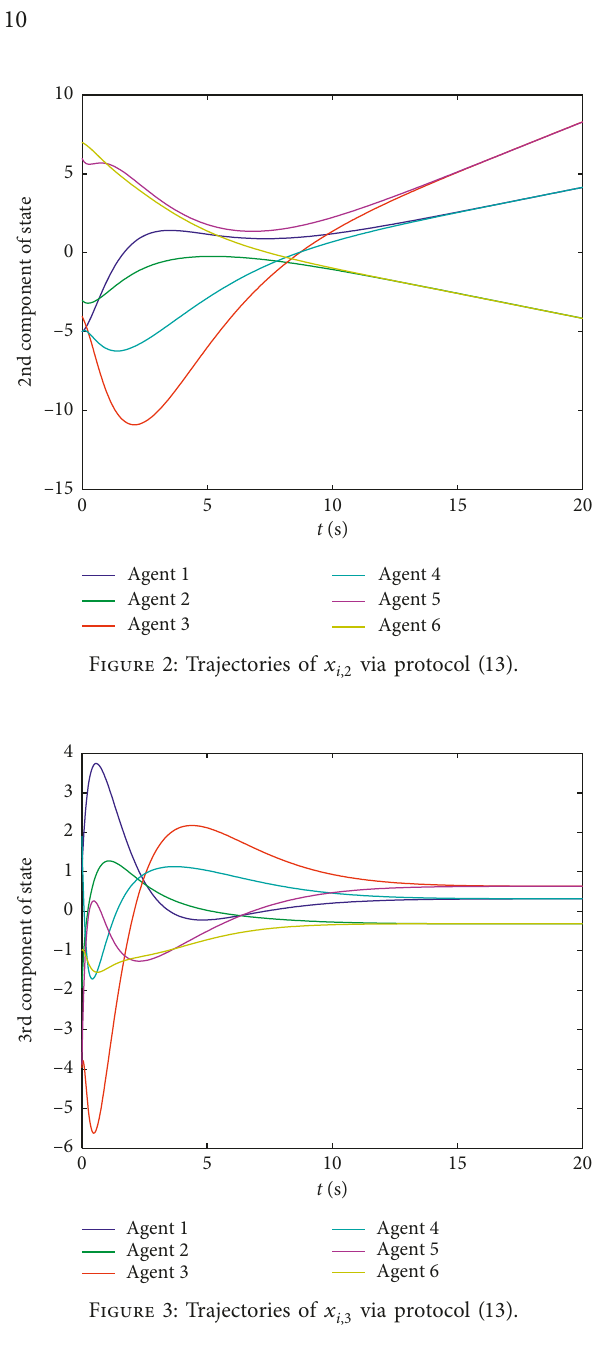
i, 3 via protocol (13).